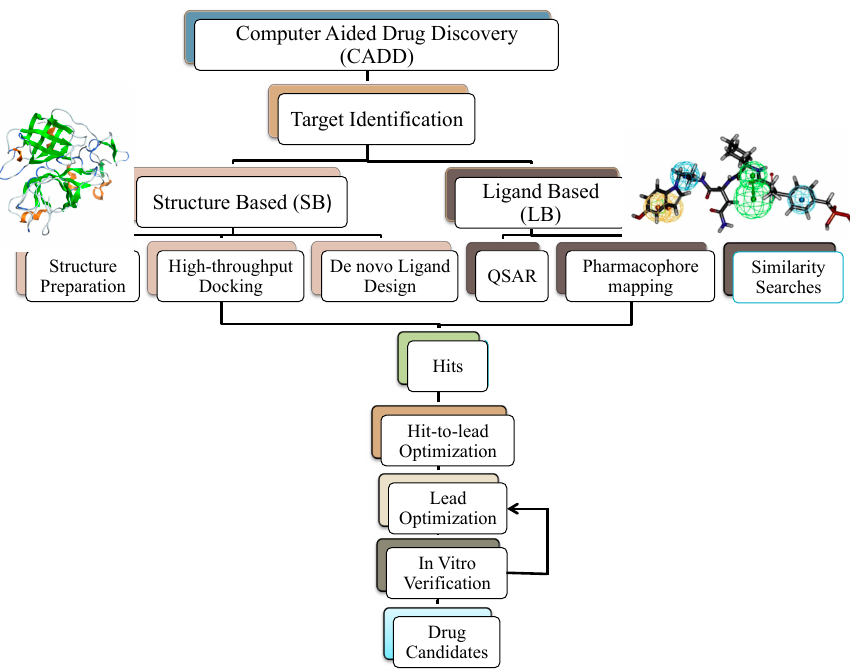
Figure 8. Schematic representation of a Computer-Aided Drug Design (CADD) pipeline whose methods are mainly classified into structure-based and ligand-based methods. Hits are identified, filtered, and optimized to obtain potential drug candidates to be experimentally tested [52] .